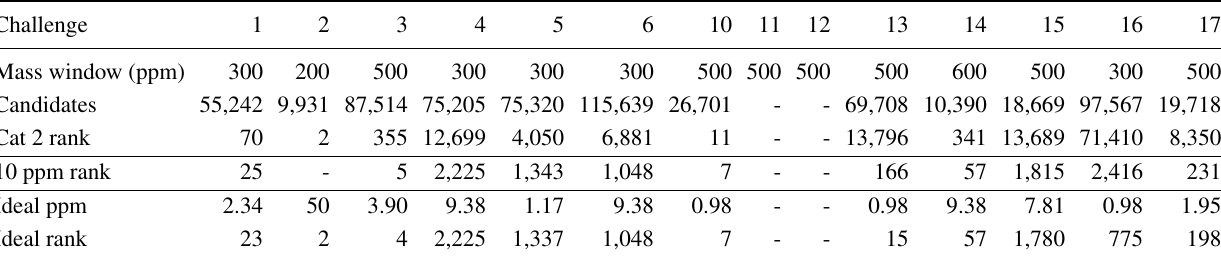
Table 3. Retrieval of candidate molecules from PubChem. The top part of the table corresponds to the CASMI setup except for replacing KEGG with PubChem. The middle part shows the results with 10 ppm mass window with PubChem. The bottom rows depict the best possible results that could be obtained if the optimal mass window width was